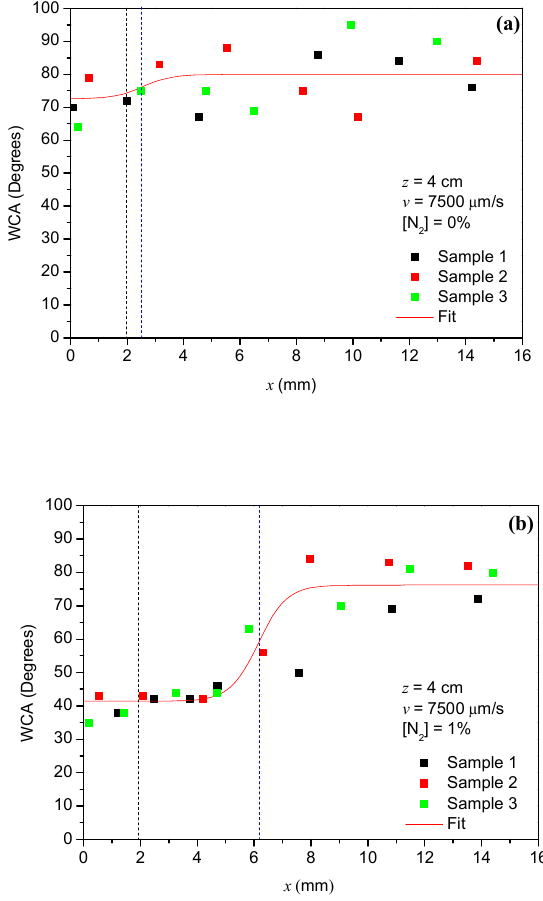
Figure 6. Water contact angle profiles after ( a ) Ar and ( b ) Ar-N 2 postdischarge treatment.